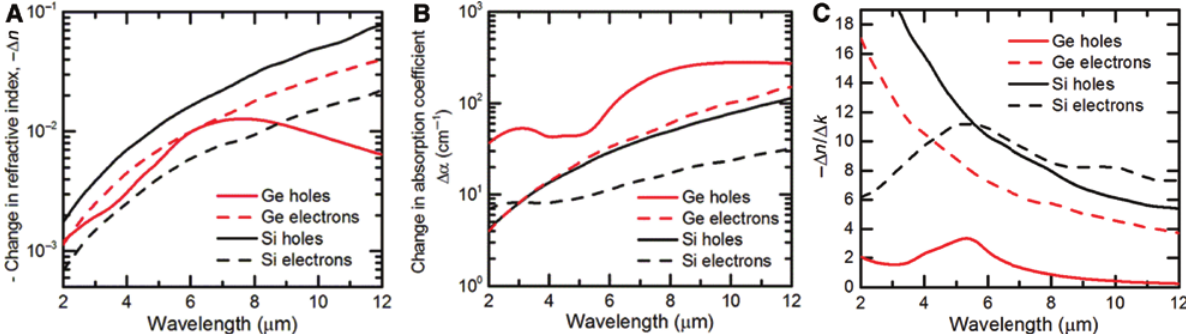
Figure 10: Free-carrier-induced changes of (A) refractive index and (B) absorption coefficient in Si and Ge in the mid-IR; (C) wavelength scaling of the electro-optic modulation FOM − Δ n / Δ k computed from data in (A) and (B) [155] (© 2015 IEEE). The data were quoted for a fixed carrier concentration of 5 × 10 17 cm −3